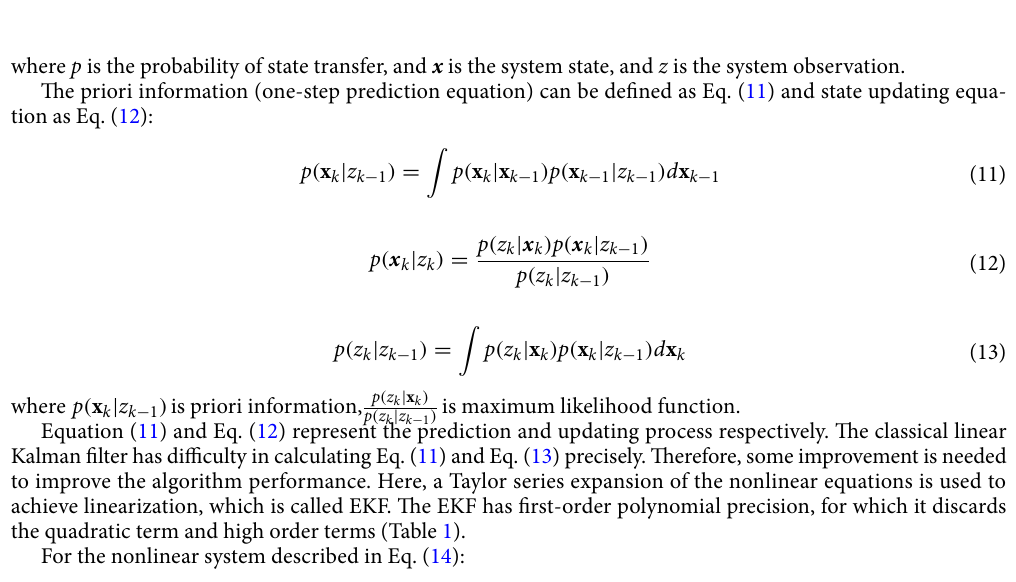
Table 1. The comparisons between diverse Kalman